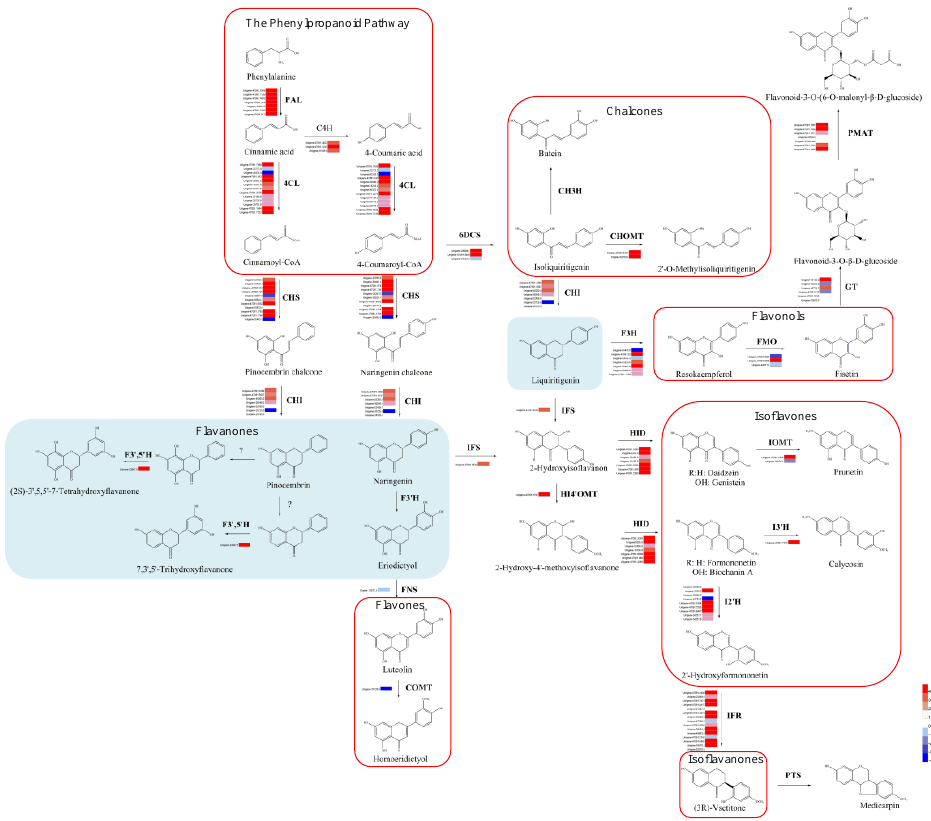
Figure 5. Putative biosynthesis pathways for phenylpropanoid and flavonoid biosynthesis pathways and expression patterns of the genes for these pathways in D. odorifera.